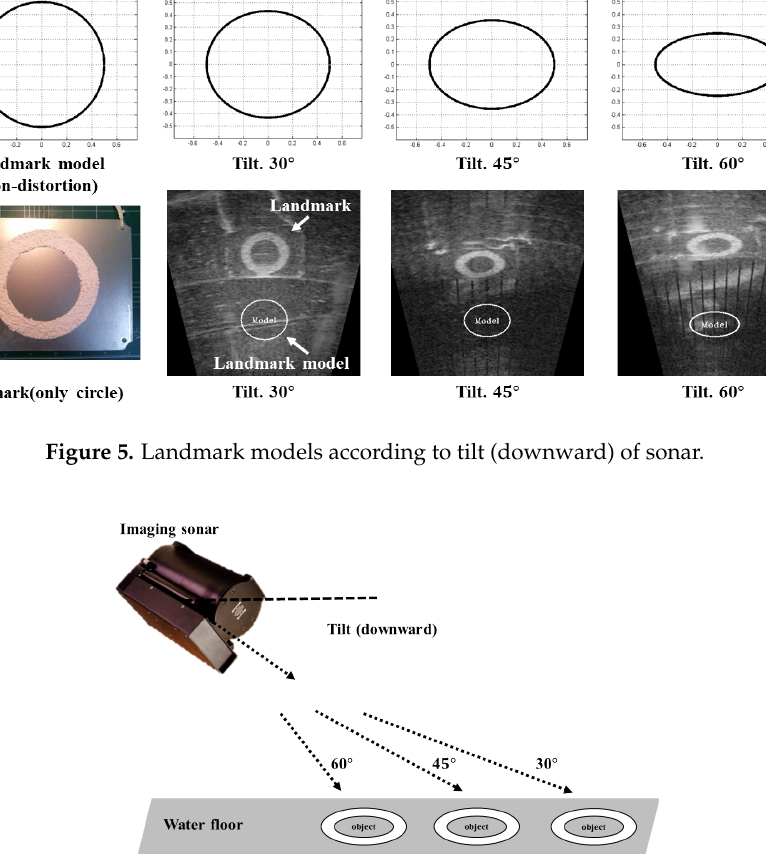
Figure 6. Sonar set-up for acquiring an image: the object should be placed at the bottom of the sonar for a good